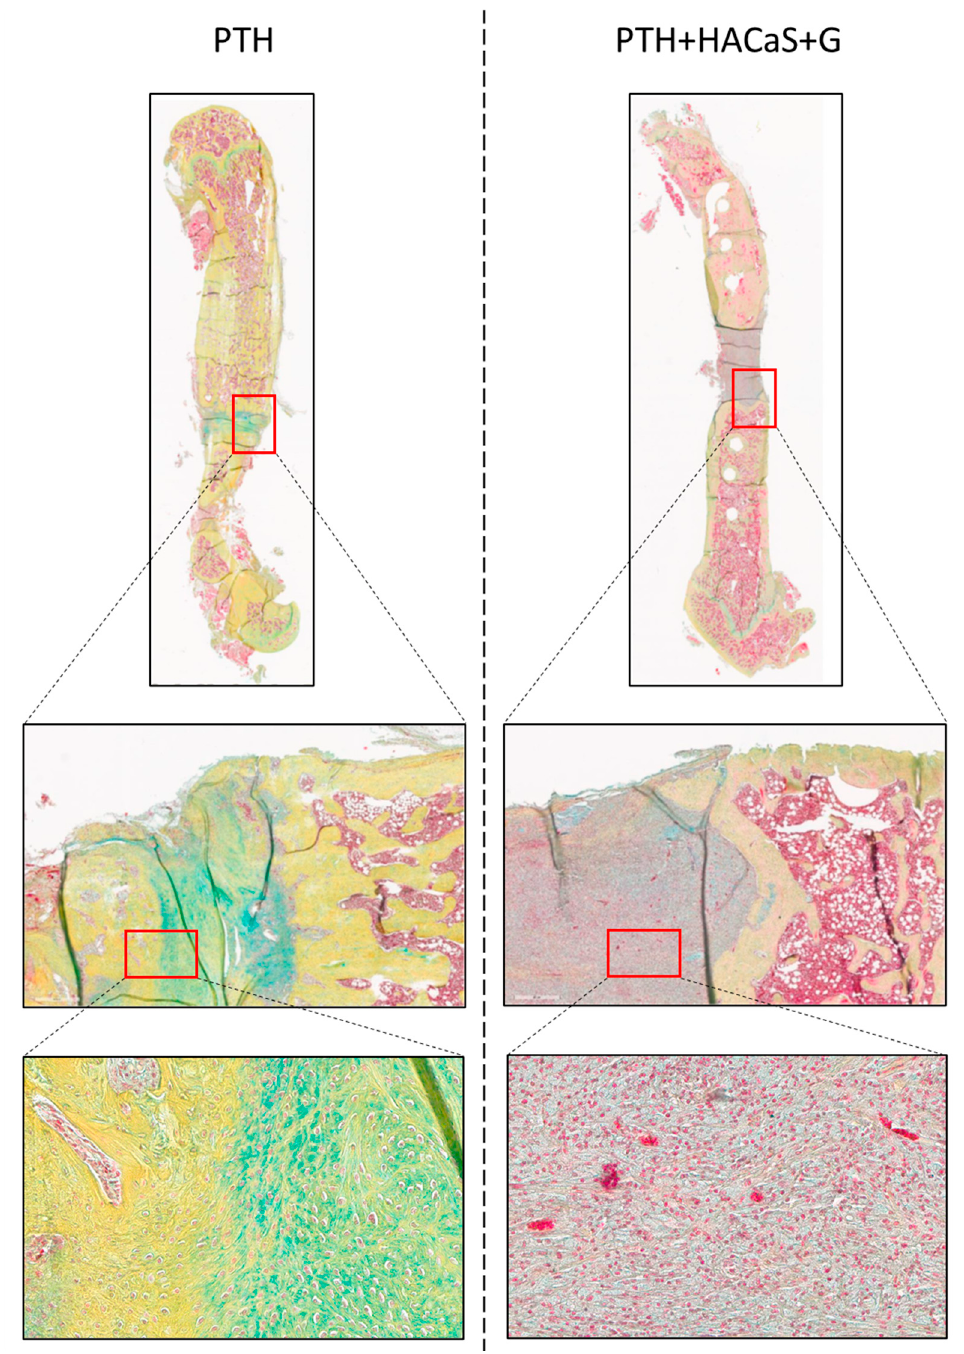
Figure 5. Pentachrome staining. Reddish cytosol in PTH+HACaS+G shows noticeable cell invasion in HACaS+G. Collagen and reticular fibers are stained yellow whereas green indicates cartilage ma- trix.